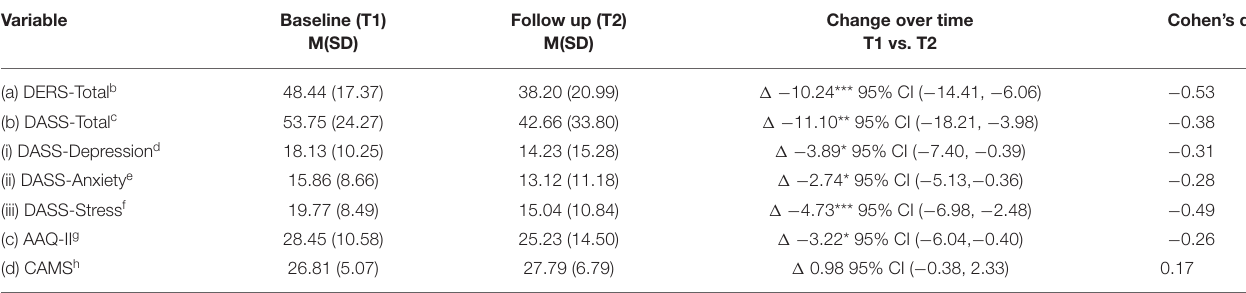
TABLE 5 | Pooled change in marginal means from baseline to follow-up across DERS, DASS, AAQ-II, and CAMS ( N = 79) a .